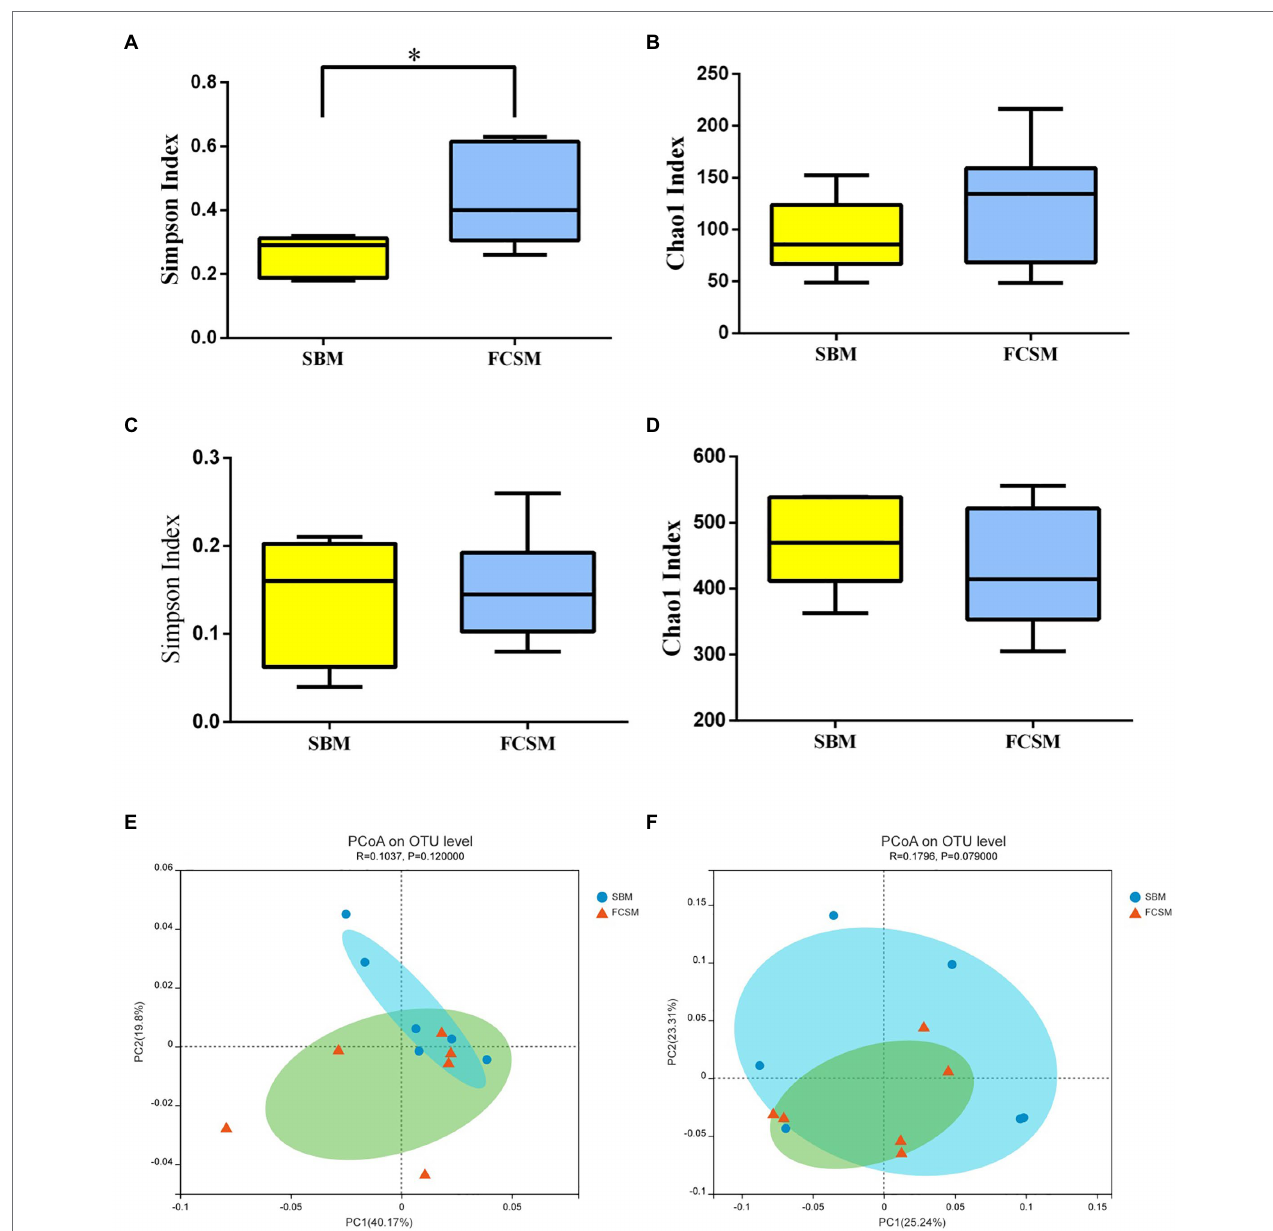
FIGURE 2 | Effects of two protein sources on the α -diversity indexes including Simpson index of ileac (A) and cecal (C) microbes, Chao1 index of the ileac (B) and cecal (D) microbes, β -diversity of the ileac (E) and cecal (F) microbes in piglets. The individual minipig was regarded as the experimental unit ( n = 6). SBM, soybean meal; FCSM, fermented cottonseed meal. * p <